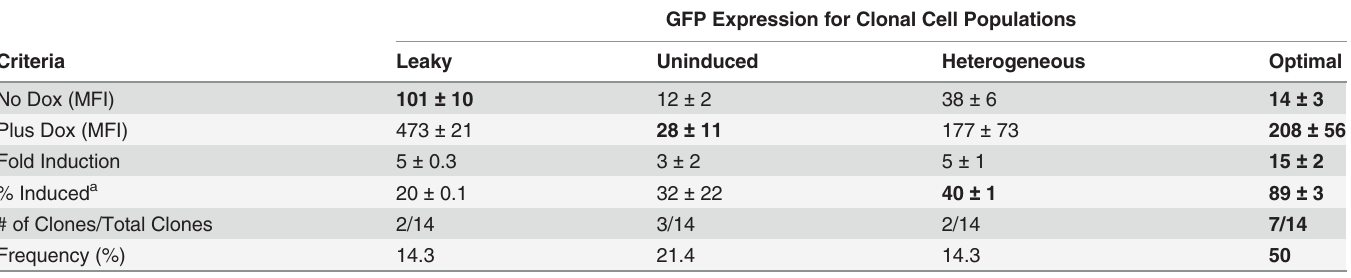
Table 3. Phenotypes of cell lines generated using the inducible HSV1-IE bidirectional promoter and Sleeping Beauty transposon-mediated integration.